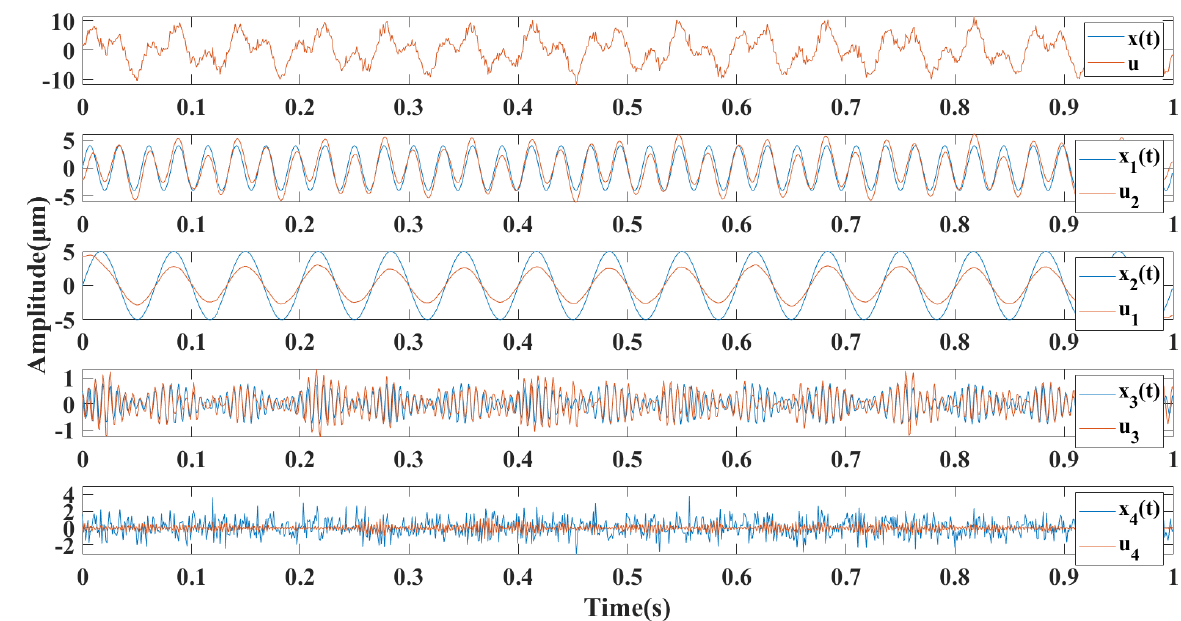
Figure 1. Modes comparison between pre − VMD and post − VMD signals.